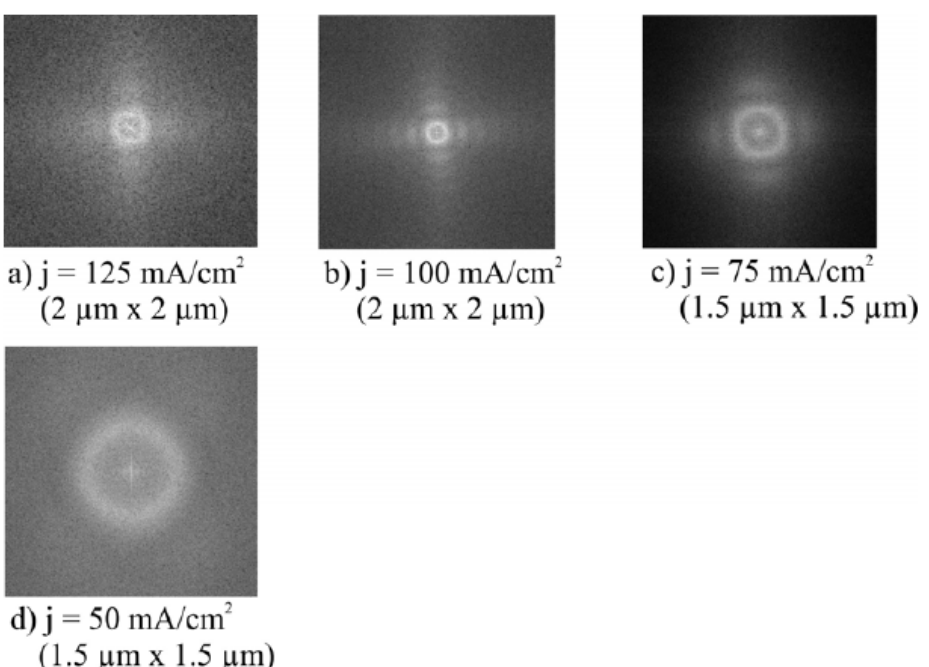
Figure 8. Fourier Transform images corresponding to the top view pictures of Figure 3a–3d (images a and b are taken from [83]. The four fold symmetry of the self- assembled pore arrangement can be recognized. The regularity deceases with decreasing pore-diameter and vanishes below a certain value.